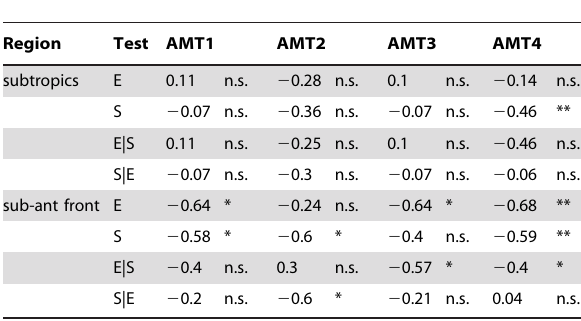
Table 2. Mantel and partial Mantel test comparisons between community similarity and spatial distribution (i.e., geographic distance between sampling sites), and environmental distance (nutrient availability).